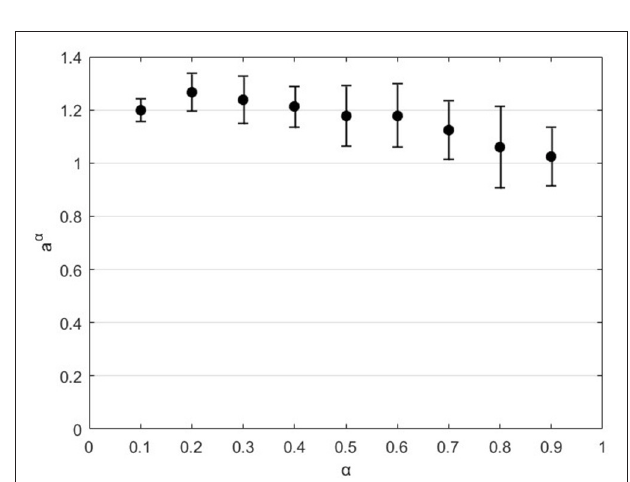
FIGURE 4 | Estimation of the slope a α . Values are mean ± SD from n = 10 simulated signals for each value of α .